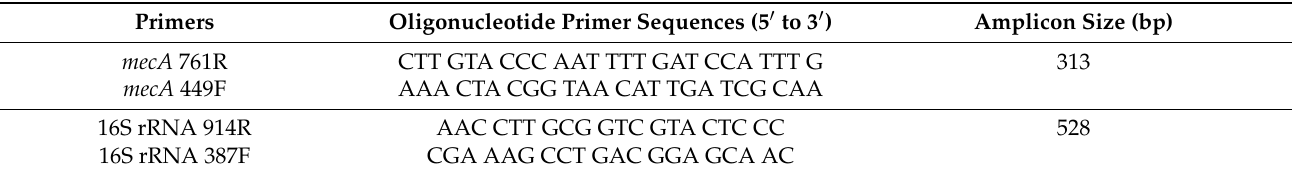
Table 4. PCR primer sequences for the detection of